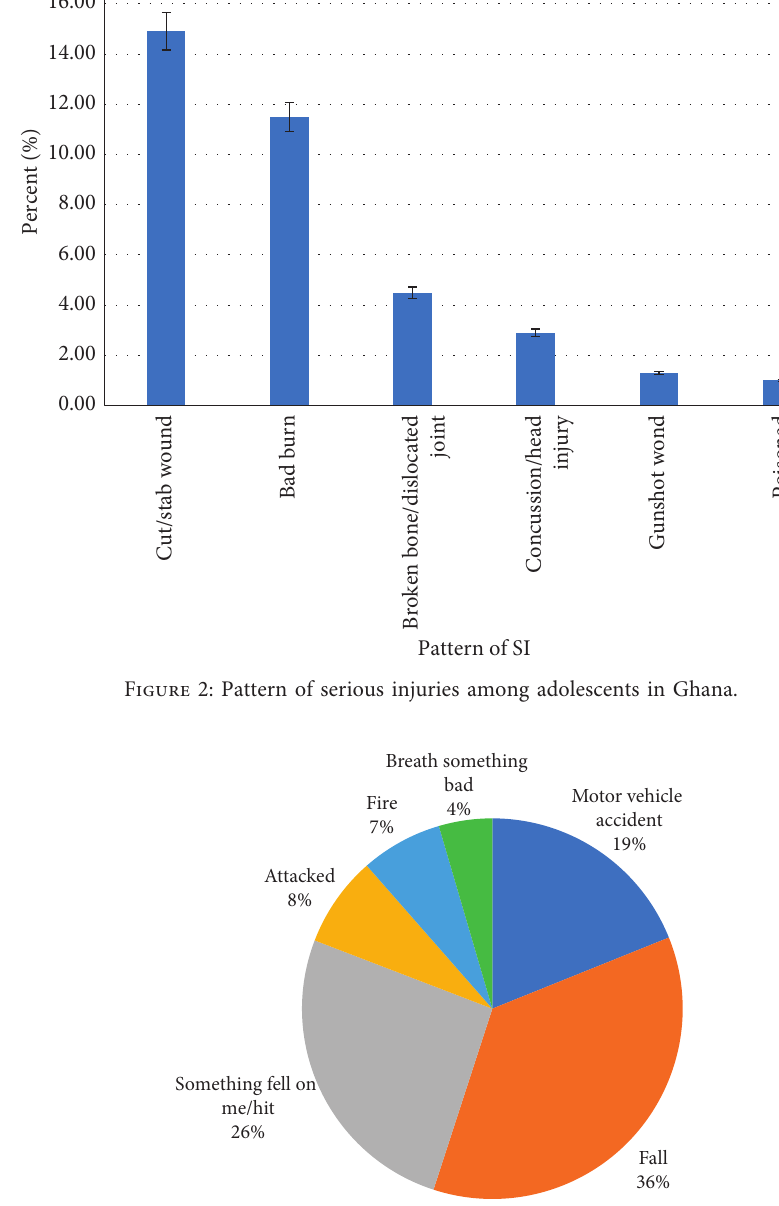
Figure 3: Cause of serious injuries among adolescents in